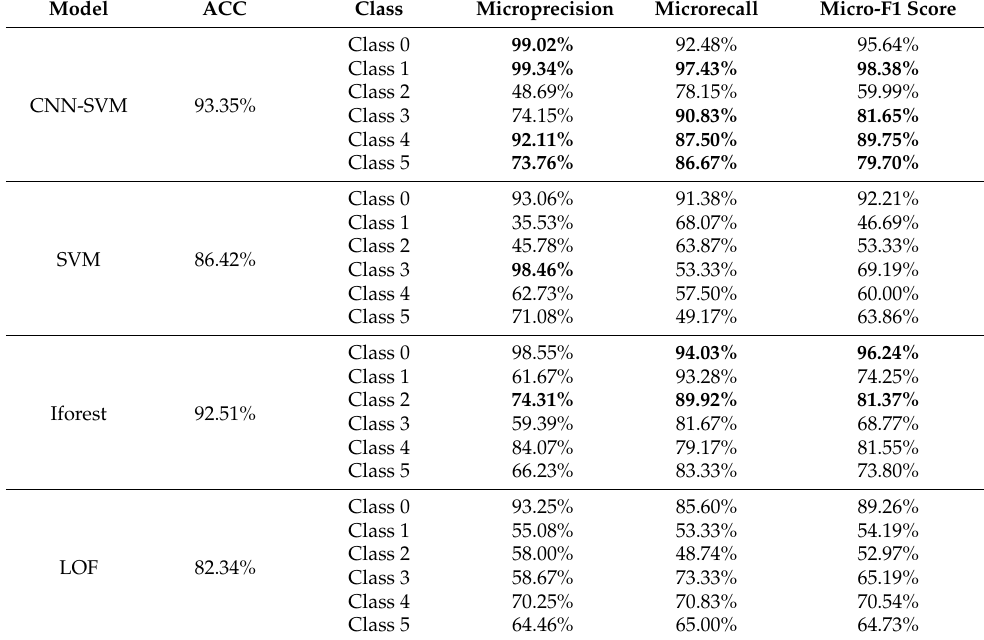
Table 7. The detailed performance indicators of each model. Class 0 indicates normal data, Class 1~5 indicate the anomaly categories of air temperature, air humidity, and soil humidity of 20 cm, 40 cm, and 60 cm under the experimental area, respectively.